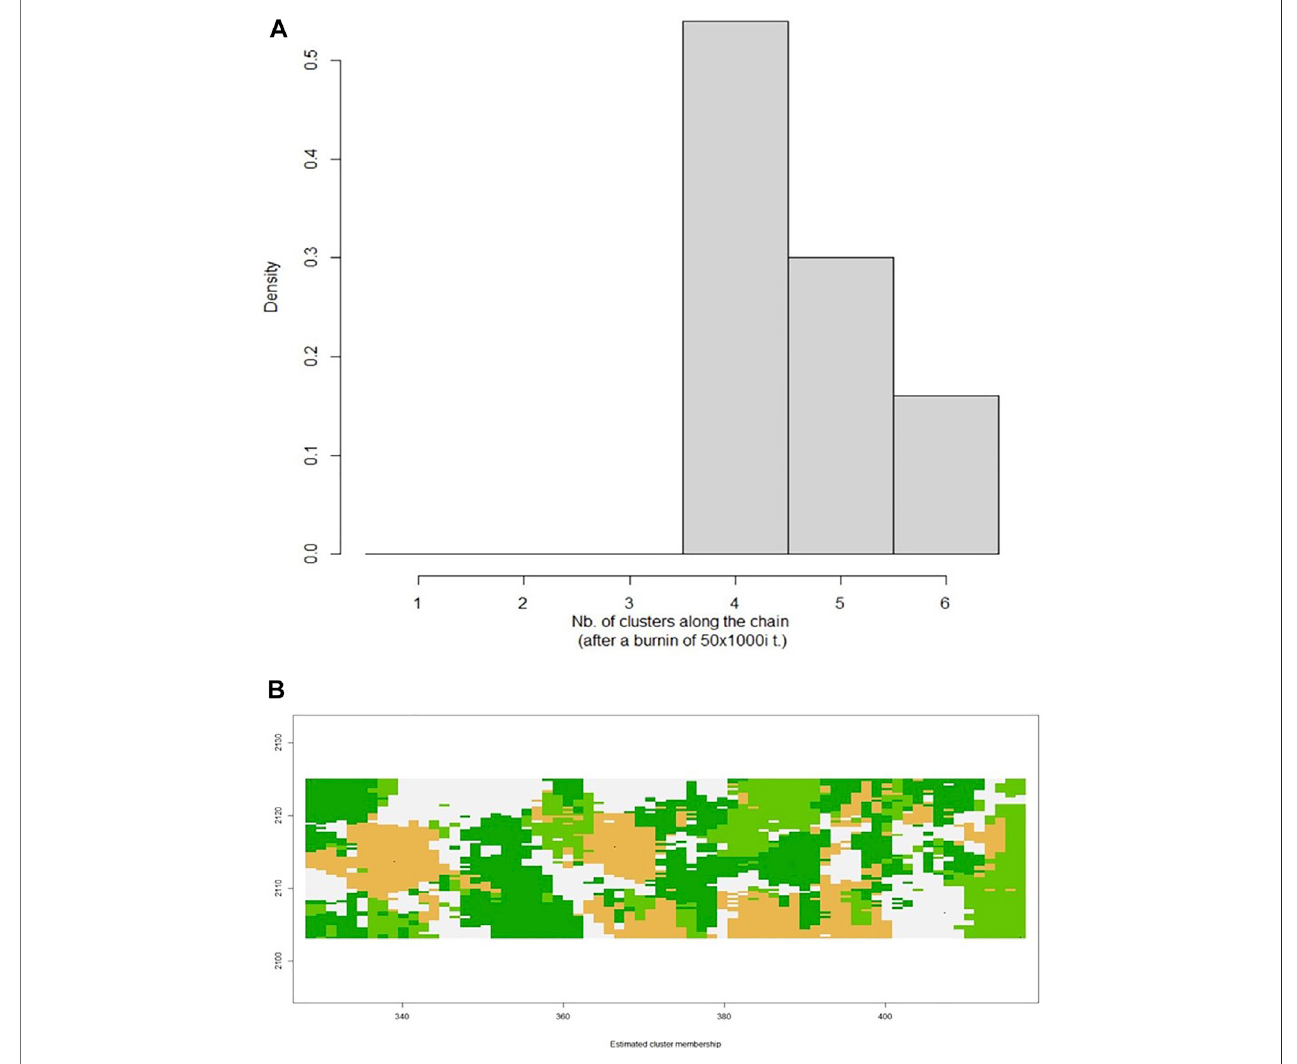
FIGURE 6 | (A) Graphical representation of the number of clusters de fi ned in the data set with Geneland, with k (cid:1) 4 being the optimal number of clusters. (B) Posterior mode of population membership. Different colours denote different clusters.